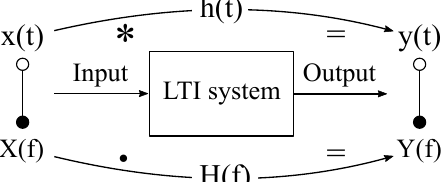
Figure 2. Basic principle of signal processing through an LTI system in time and frequency domain (adapted from Figure 7.7 in